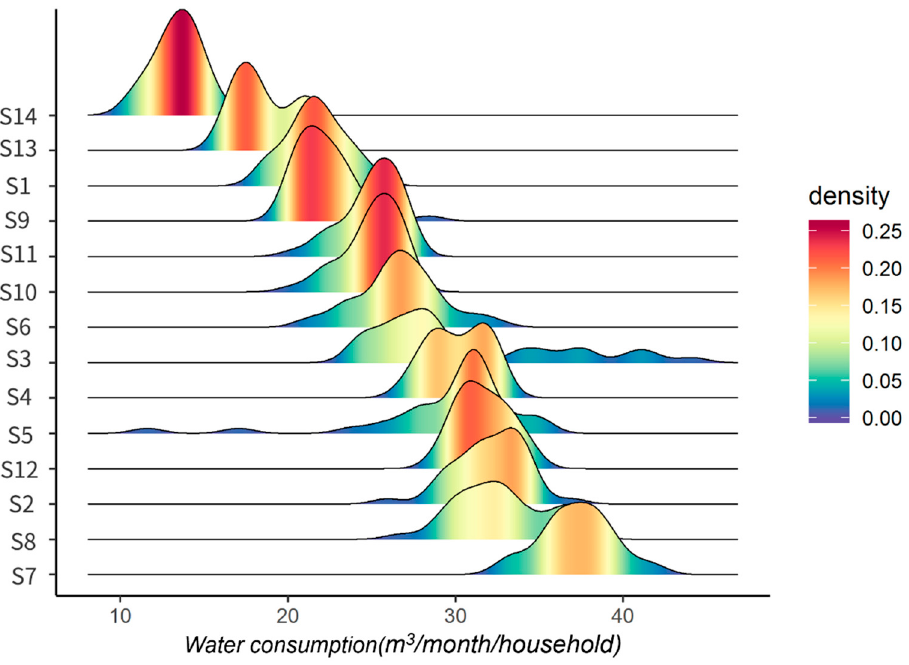
Figure 4. The density curves of water use per household (m 3 ) during 2011–2017 in the 14 commu- nities.